Question: In one sentence, what is this figure communicating?
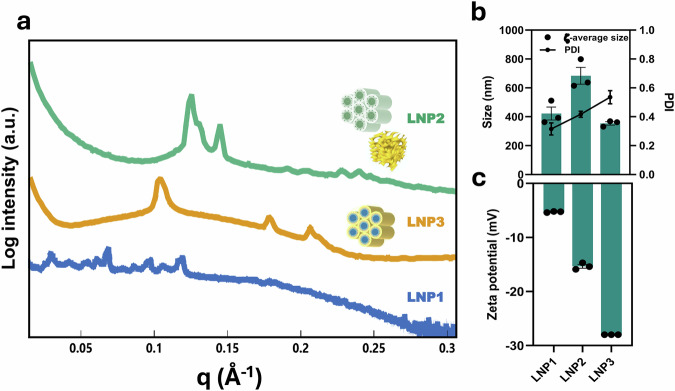
Answer: Liquid crystalline lipid nanoparticle structural and physicochemical characterization revealing the properties of the PUFA-enriched LNPs depending on the functionalization with PACAP and RVG‑OL peptides. a Synchrotron small-angle X-ray scattering (SAXS) patterns of monoolein-based nanoassemblies stabilized with Pluronic F127 (LNP1: MO-EPA-Plu) in excess aqueous medium and liquid crystalline nanoparticles of mixed types (hexosomes and cubosomes) formed by coencapsulation of ginkgolide B and quercetin and subsequent functionalization with PACAP and RVG-OL (LNP2: MO-EPA-Plu-GB-Quer + PACAP/RVG-OL and LNP3: PL-EPA-Plu + PACAP). Measurements were performed at 22 °C. b , c Hydrodynamic diameter, polydispersity (PDI), and zeta potential of LNP1-type PUFA-LNPs or those functionalized with PACAP and RVG-OL cell-penetrating peptides (LNP2) or PACAP (LNP3)